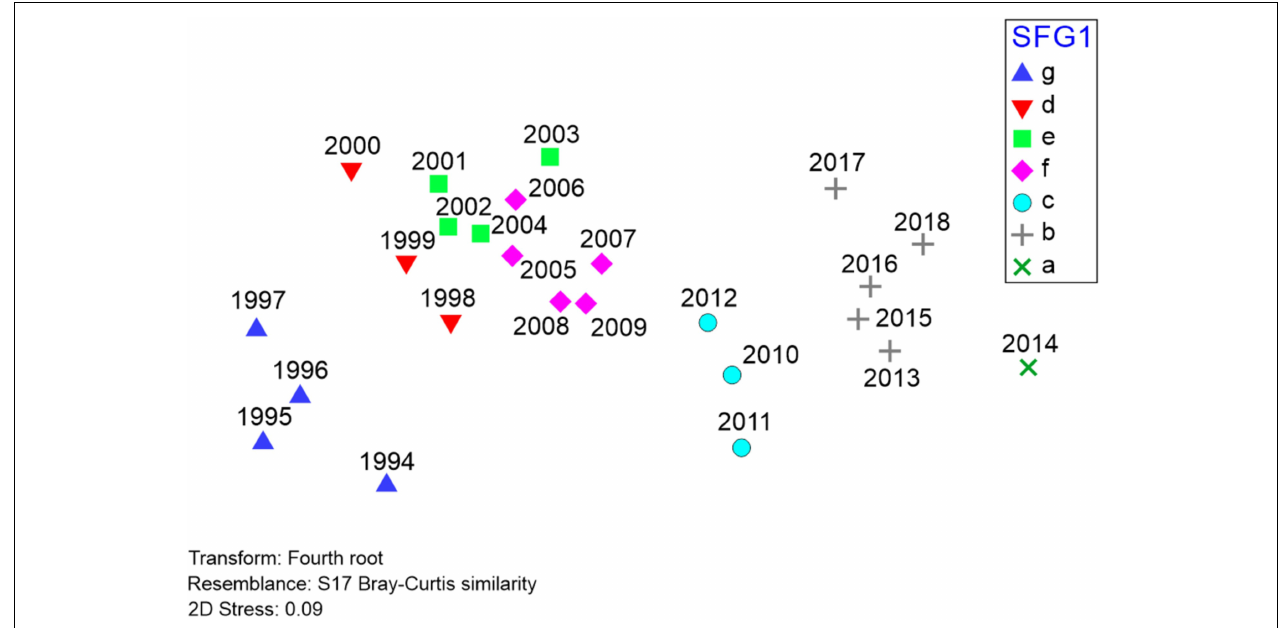
FIGURE 6 | Results of non-metric multidimensional scaling (nMDS) of Barataria Bay trawl survey catches, 1994–2018 (data and symbols as in Figure 5 ). Relative positions of different years are determined by Bray-Curtis similarities between all possible pairings of years, with 2D stress reflecting the extent of distortion (low distortion, in this case) created by representing these Bray-Curtis similarities in a two-dimensional Euclidean space.